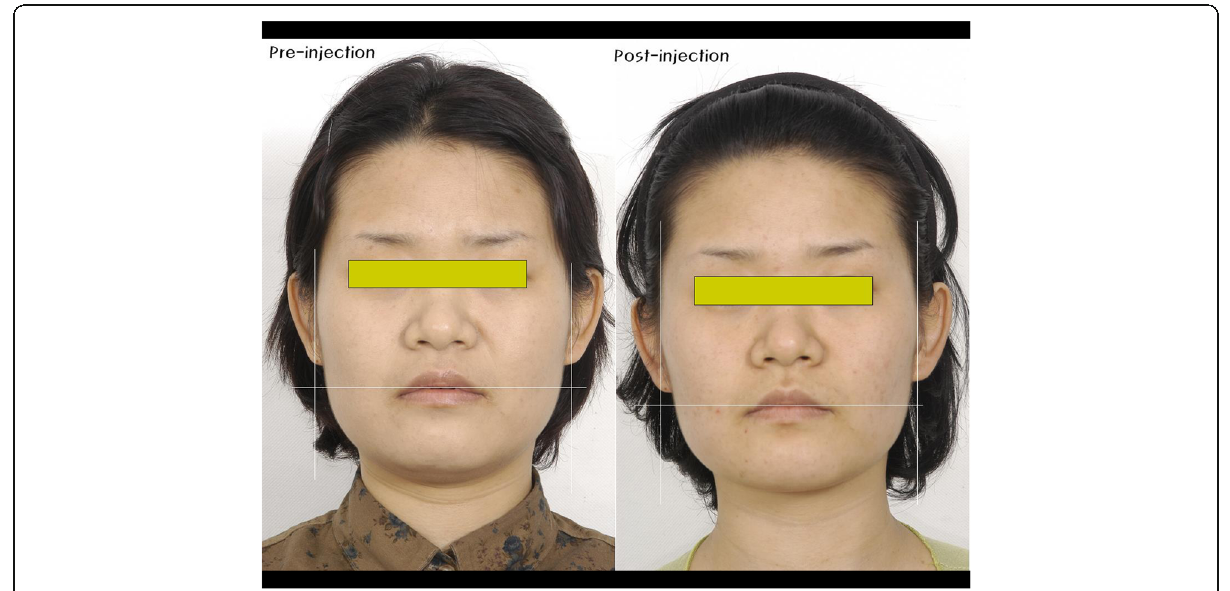
Fig. 12 A patient who had chronic migraine, bruxism, benign masseteric hypertrophy. Pre-injection of BTX (left), after 1 month clinical photo